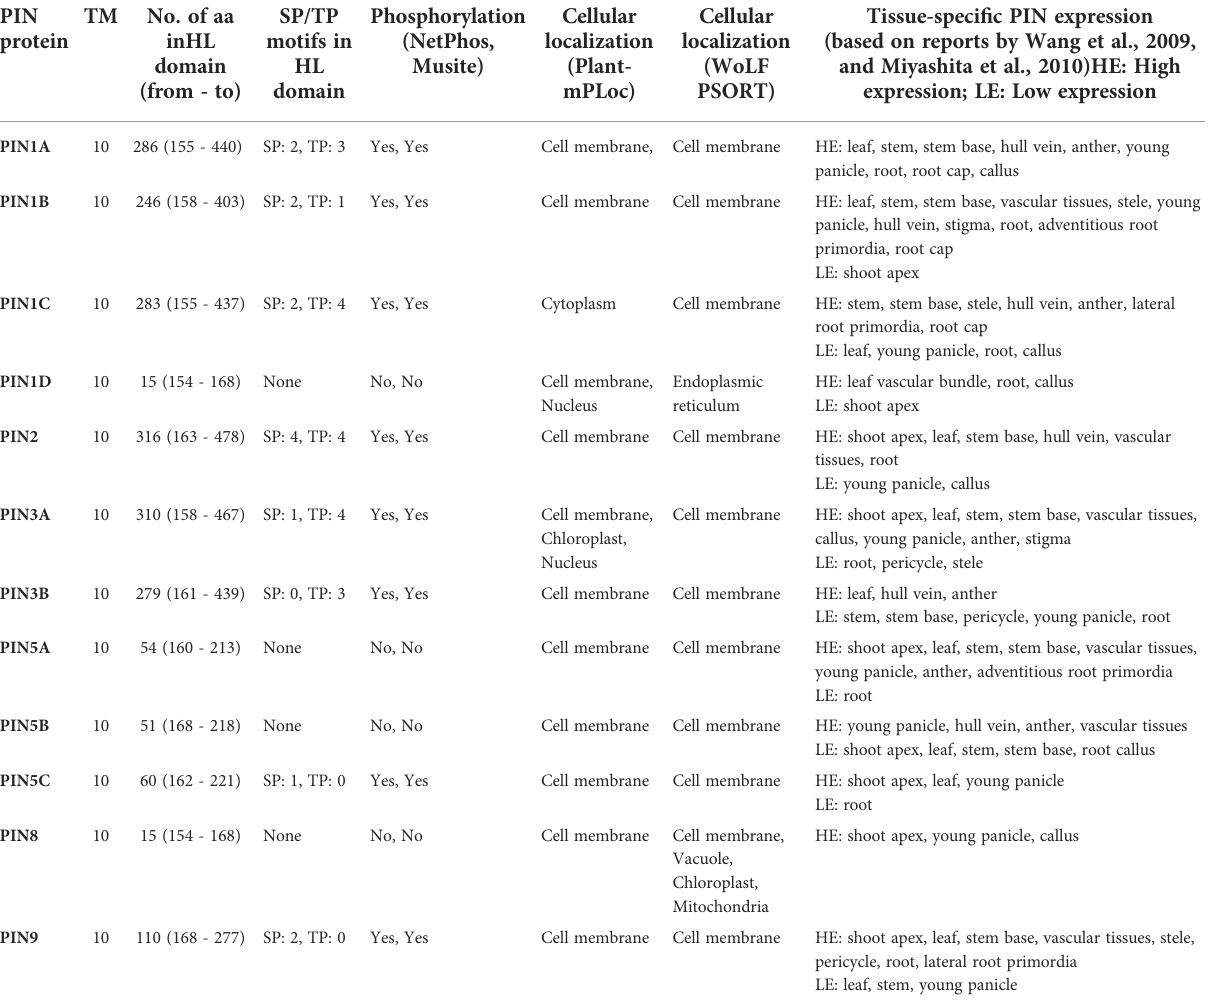
TABLE 2 Rice PIN protein characteristics (TM, number of transmembrane domains; aa, amino acids; HL, hydrophilic loop). PIN TM No. of aa protein